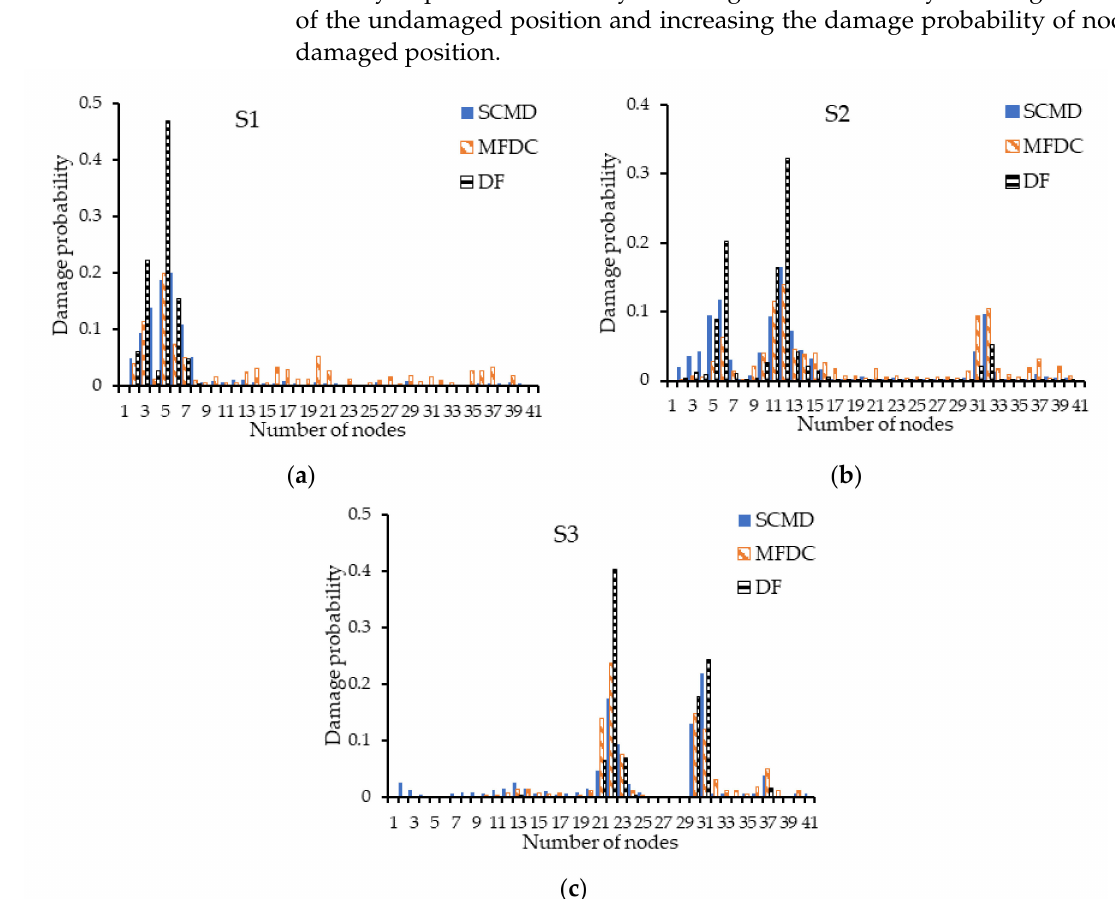
Figure 8. The results of one-stage fusion. ( a ) damage condition S1; ( b ) damage condition S2; ( c ) damage condition